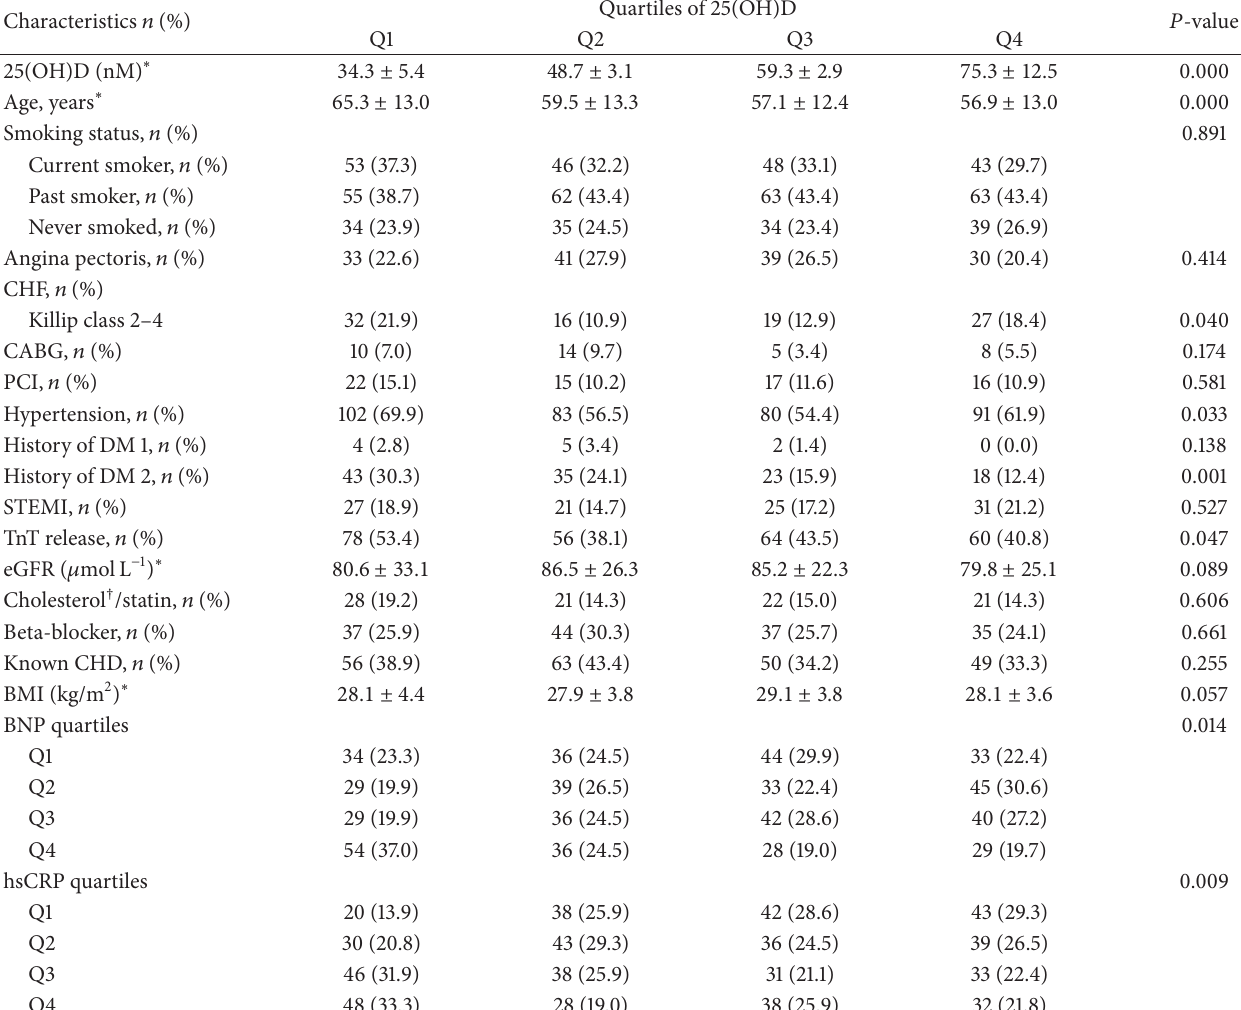
Table 2: Baseline characteristics of male patients arranged according to quartiles of 25(OH)D. Characteristics 𝑛